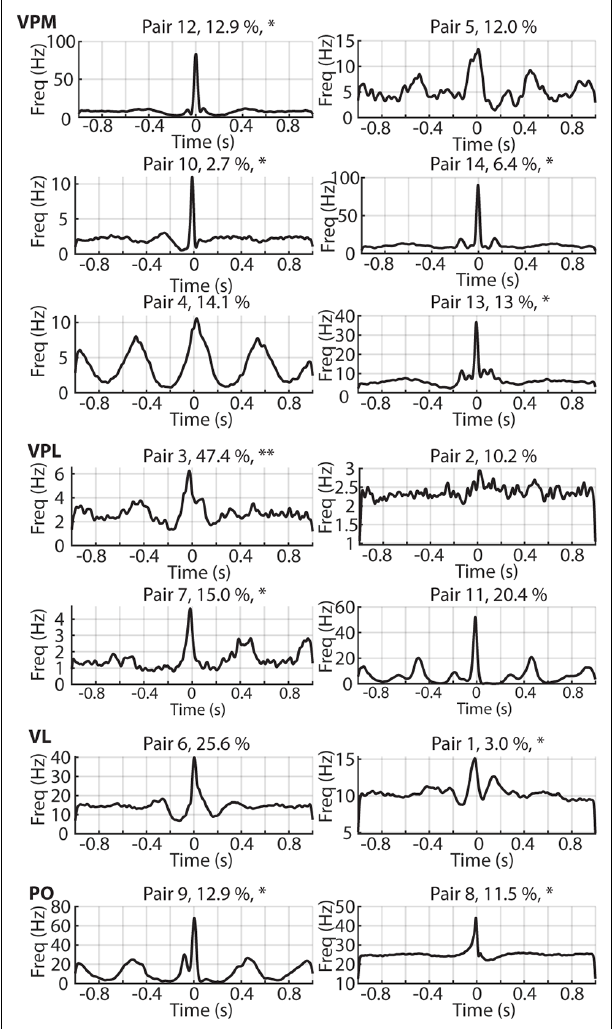
FIGURE 3 | Dependency of the correlation patterns on ECoG state. (A) Sample raw trace of ECoG activity with transitions between synchronized to desynchronized state, and back again, indicated by dashed lines. (B) Comparison of the observed correlation patterns generated when the triggering spike occurs during synchronized (blue) and desynchronized (red) ECoG activity, with the Pearson correlation coefficient indicated. (C) Relationship between the mean peritrigger peak deflection in a thalamic neuron pair correlation and the time ratio spent in the desynchronized ECoG state during the recording of the pair.